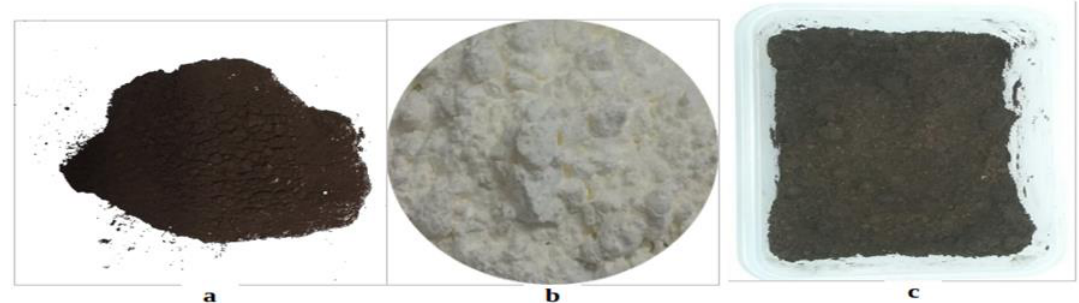
Figure 1. The used materials for the briquettes preparation: ( a ) Olive pomace, ( b ) corn starch, and ( c ) the mixture 85%-15%, respectively.